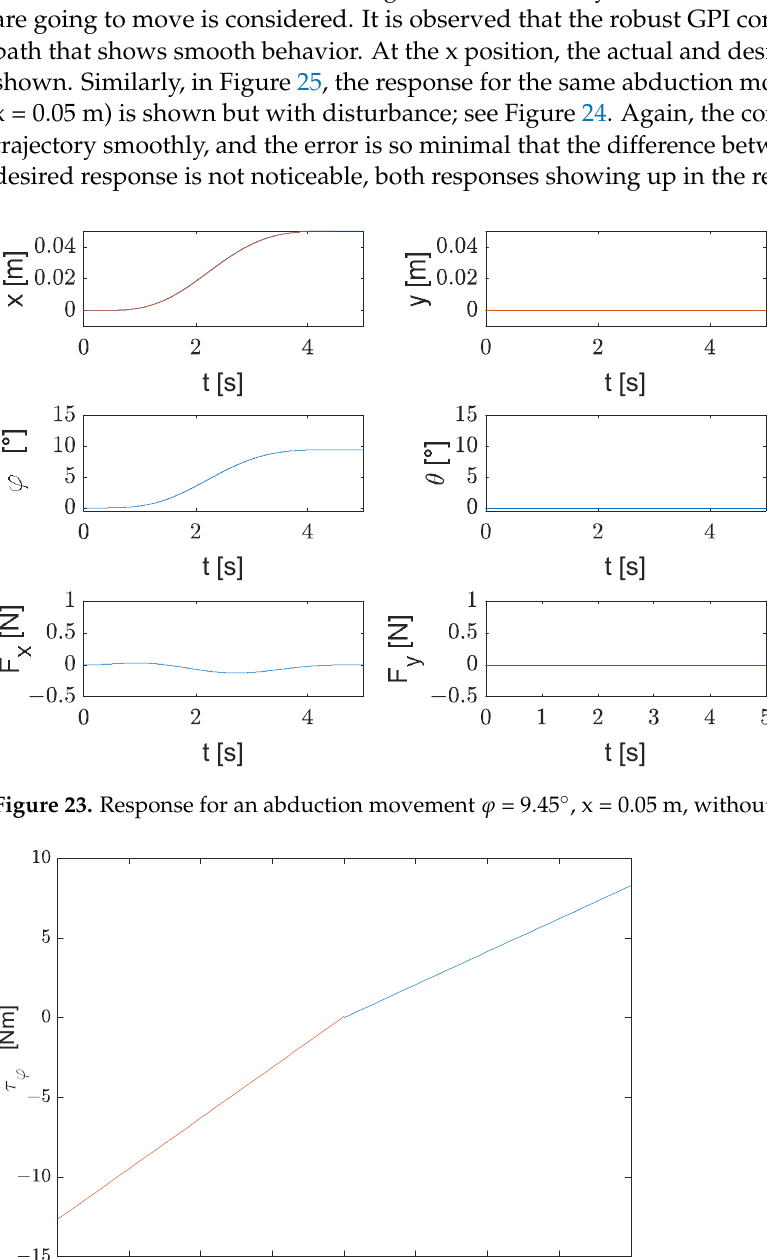
Figure 24. Perturbation for an abduction (blue line)-adduction (red line) movement.